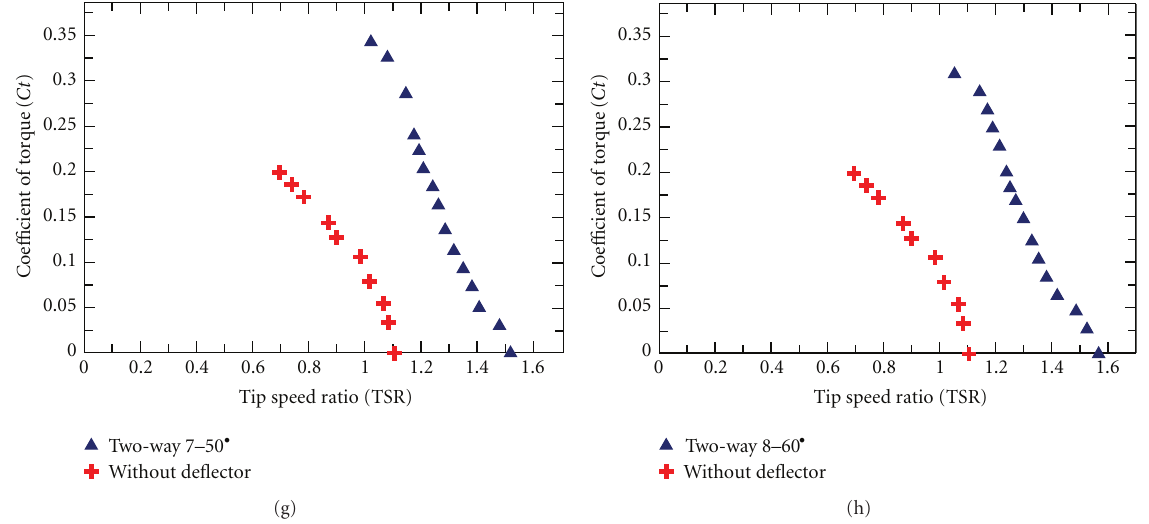
Figure 12: Variation of coe ffi cient of torque with TSR for modified Savonius rotor with and without two deflector plate.